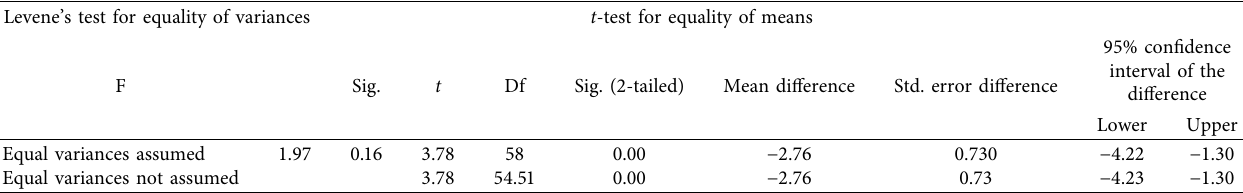
Table 9: Inferential statistics of the experimental and control groups in the vocabulary